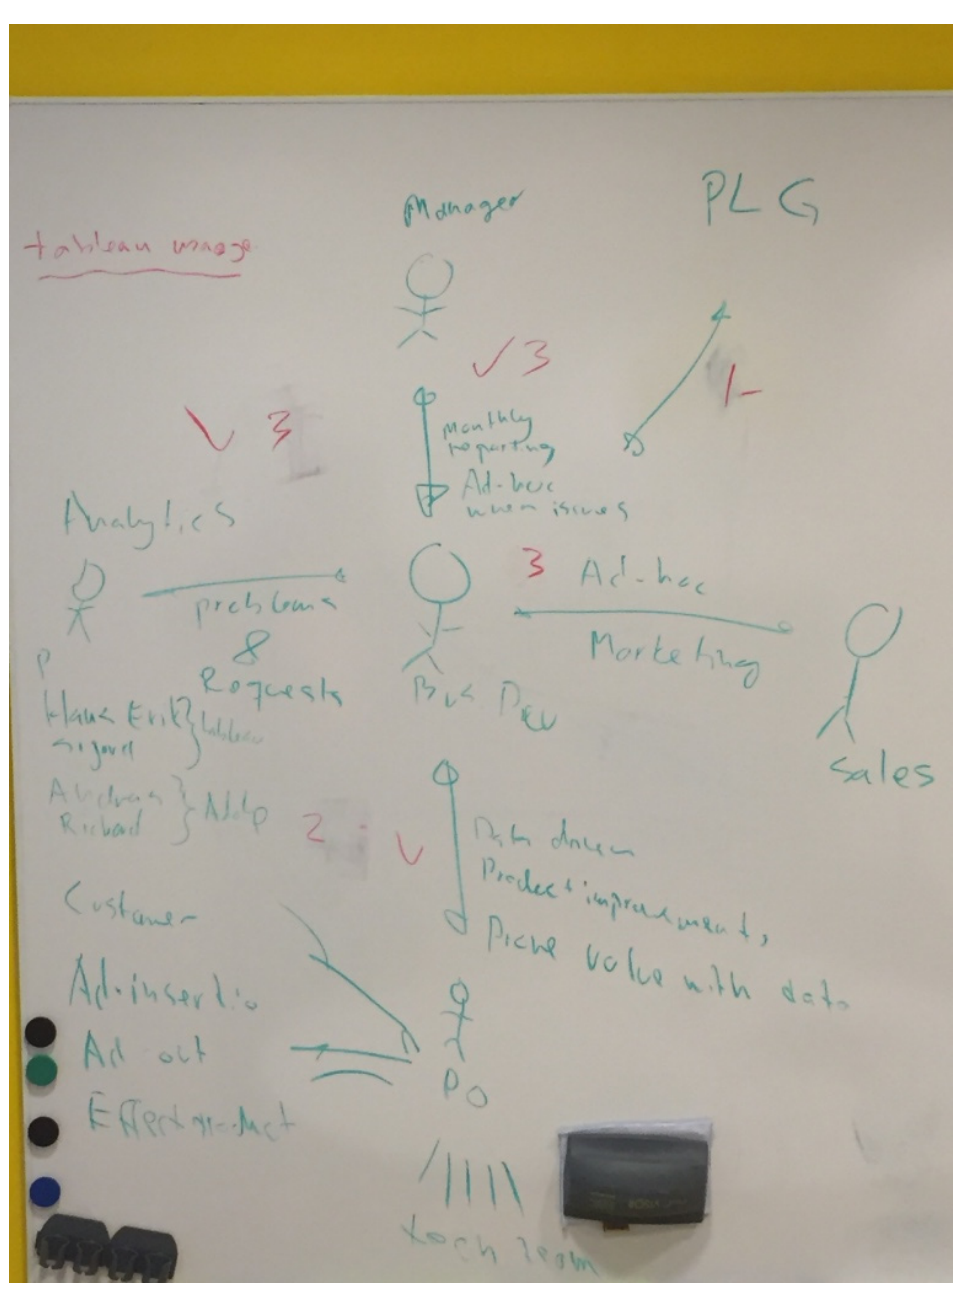
Figure 2. Mock-up example.